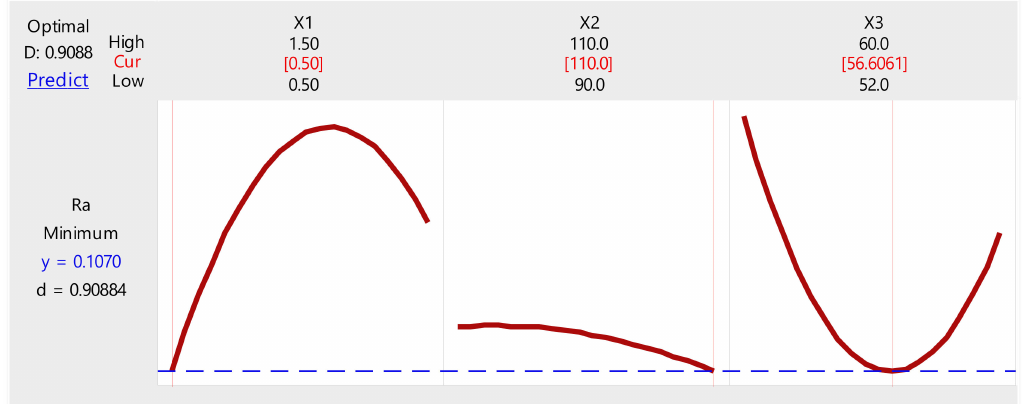
Figure 7. The optimized graphs for surface roughness R a .